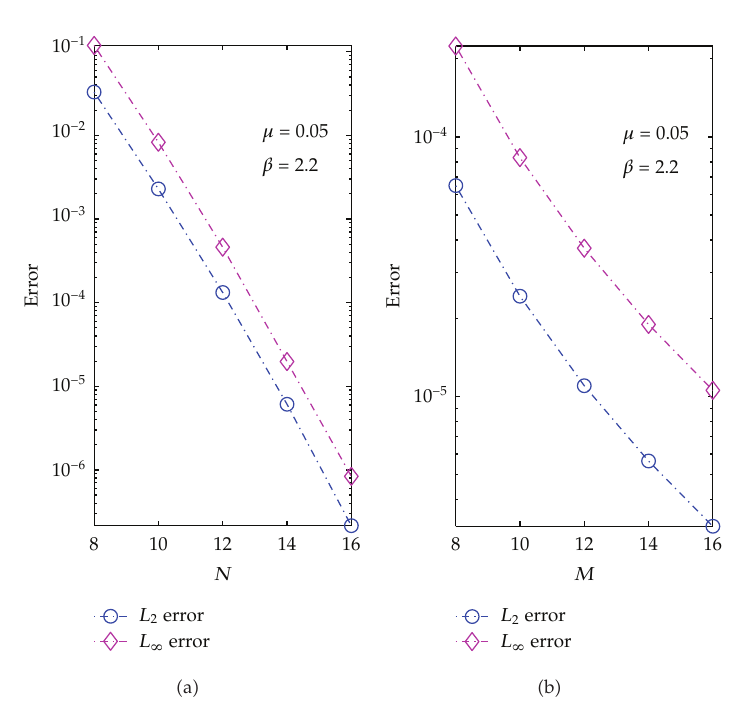
Figure 5: y -axis is log scale. (cid:4) a (cid:5) Errors versus N with M (cid:6) 16 ,μ (cid:6) 0 . 05. (cid:4) b (cid:5) Errors versus M with N (cid:6) 16 ,μ (cid:6) 0 .